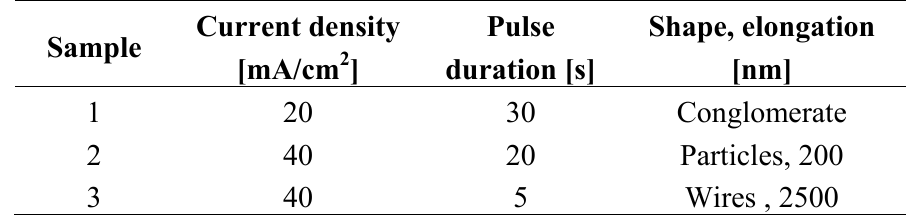
Table 3. Electrochemical parameters of the galvanic process to achieve differently shaped